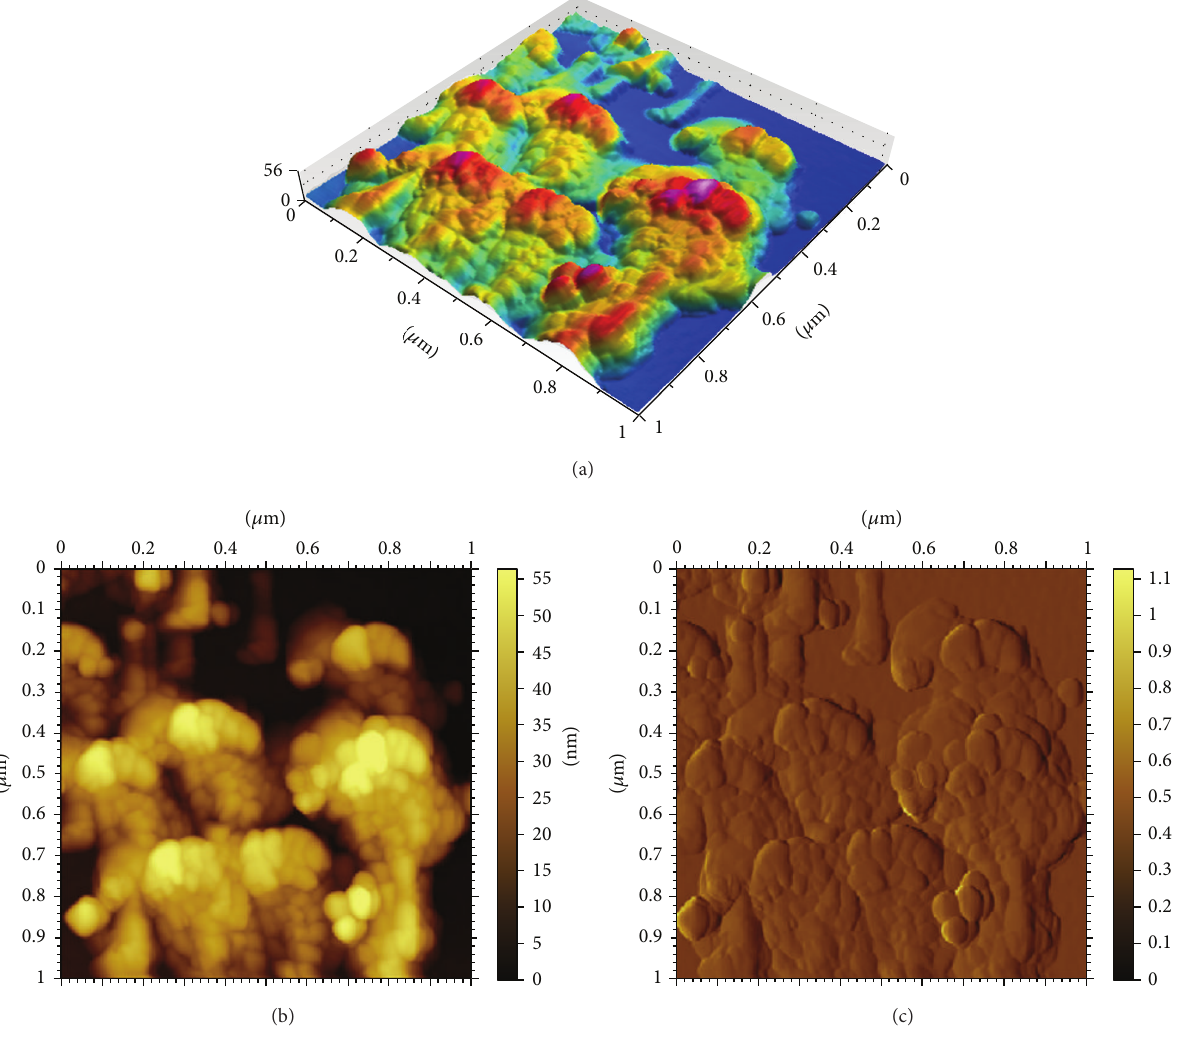
Figure4:AFMtopographyobservedfor 𝛼 -Fe 2 O 3 nanoparticle-modifiedelectrodein(a)angleview(3D),(b)topview(2D),and(c)amplitude view